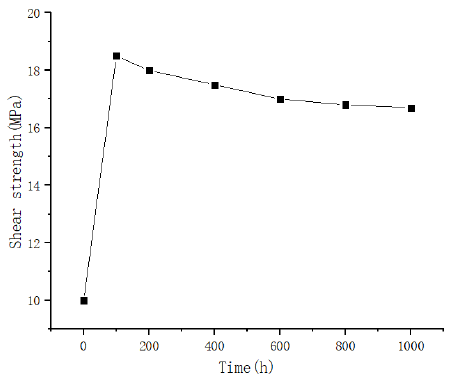
Figure 11. Shear strength of epoxy bonded joints with aging time at the temperature of 100 °C.